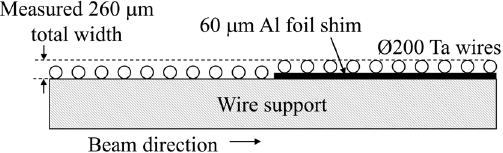
FIG. 8. Schematic (not to scale) of shimming of Ta diffuser wires with thin Al